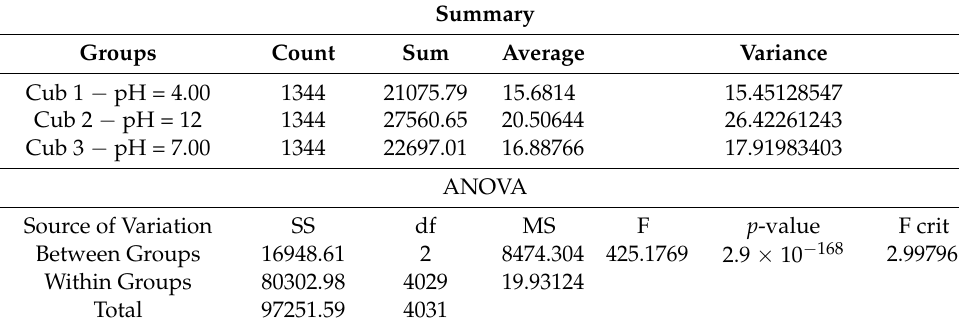
Table 4. ANOVA based on concrete strength data.